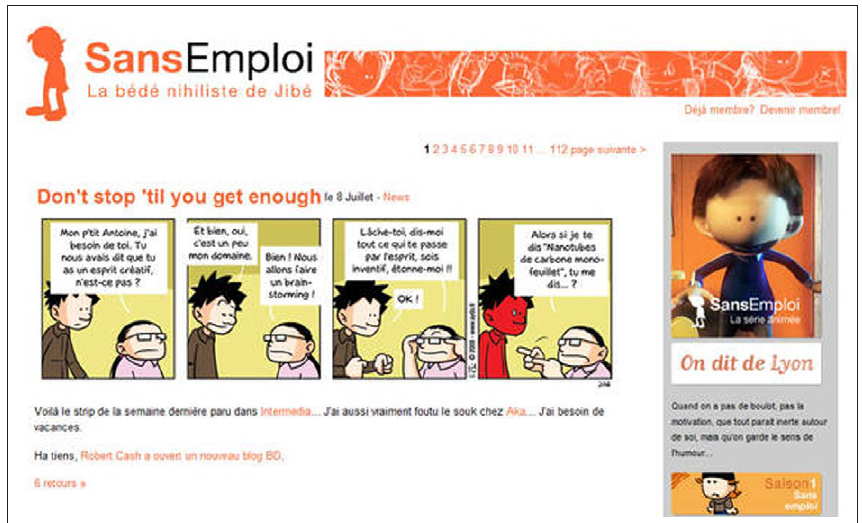
Figure 1: Jibé, Sans emploi , July 8, 2009 available at: http://web.archive.org/ web/20121014070124/http://sansemploi.chezjibe.com/ © Jibé.